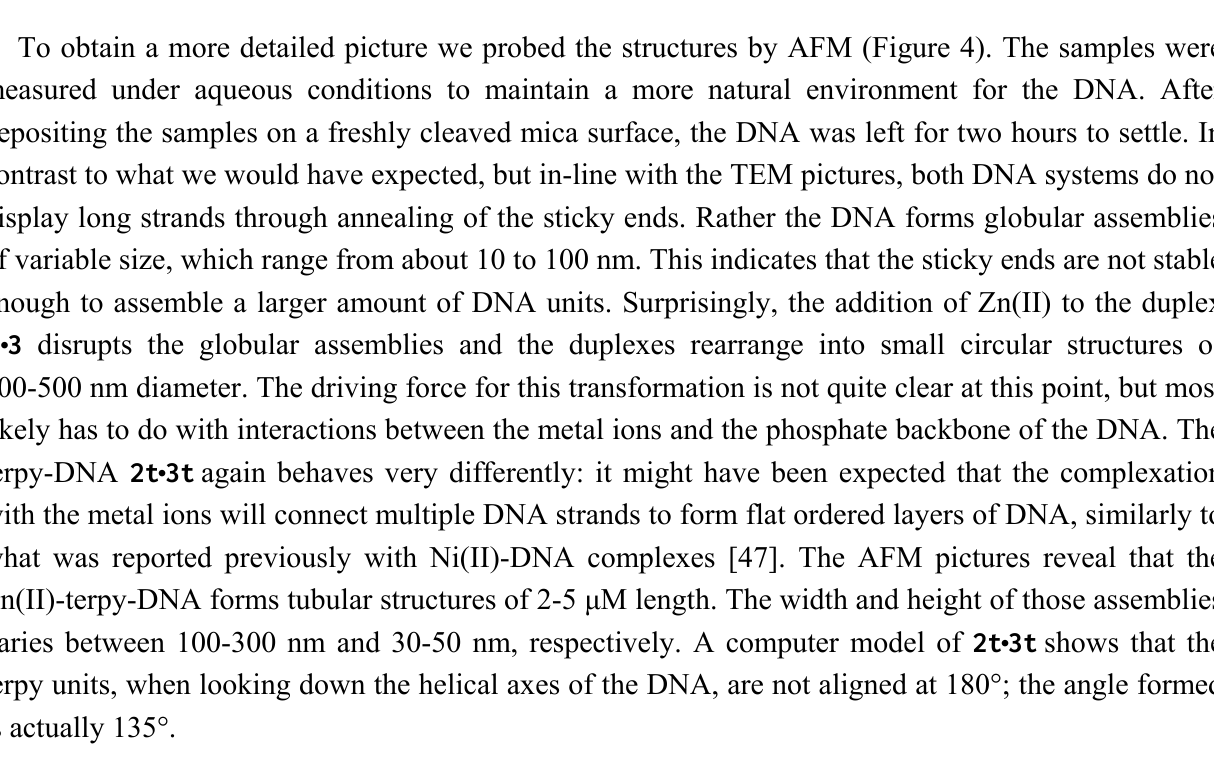
Figure 4. AFM images of the DNA systems. ( a ) 2•3 . ( b ) 2•3 + Zn(II). ( c ) 2t•3t